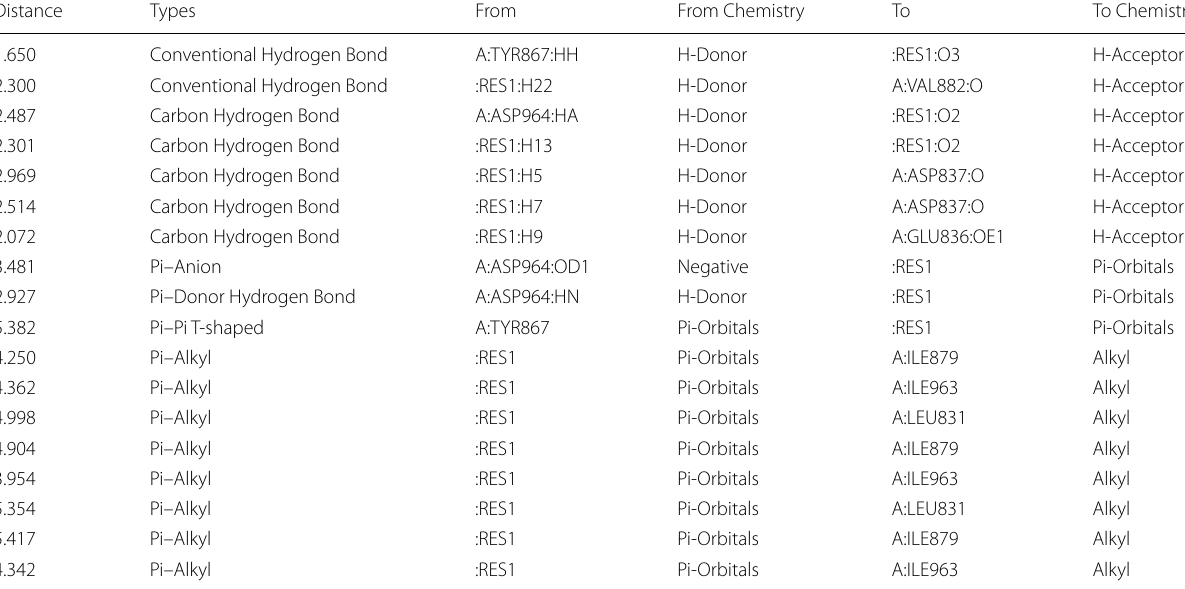
Table 5 Types of interactions in the Palomid 529–4JT6 (mTOR) receptor complex Distance Types From From Chemistry To To